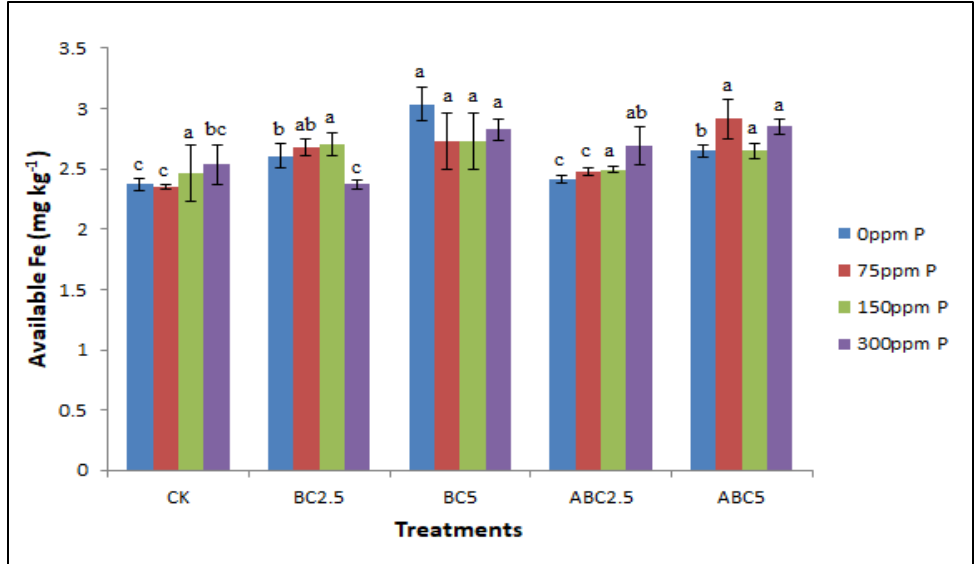
Figure 6. Effects of BC and ABC applied at different rates with different P fertilizer application rates on soil available Fe (mg kg − 1 ). Means with different letters within each fertilizer rate across each treatment indicate significant differences according to the least significant difference (LSD) test at p < 0.05. CK = Control, BC2.5 = Biochar added at 2.5% w / w , BC5 = Biochar added at 5% w / w , ABC2.5 = Acidified biochar added at 2.5% w / w , and ABC5 = Acidified biochar added at 5% w / w .